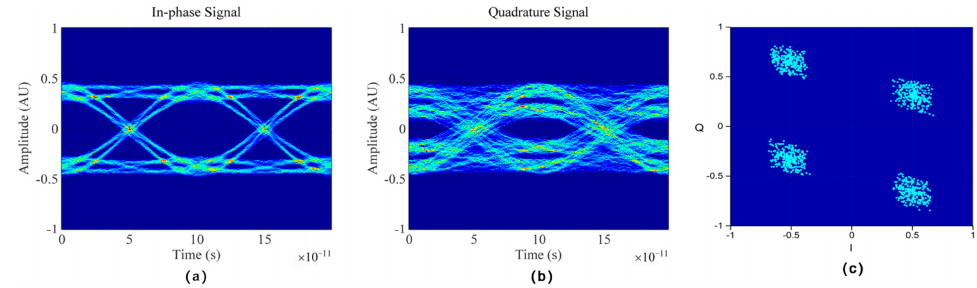
Figure 5. ( a ) In-phase signal eye diagram; ( b ) quadrature signal eye diagram; ( c ) constellation dia- gram.